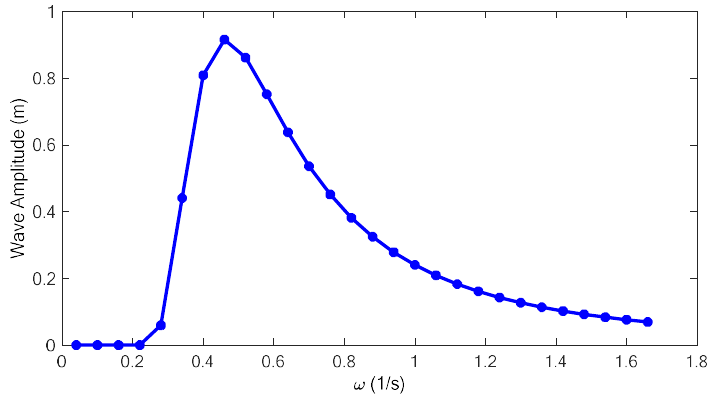
Figure 2. Time history curve of the harmonic